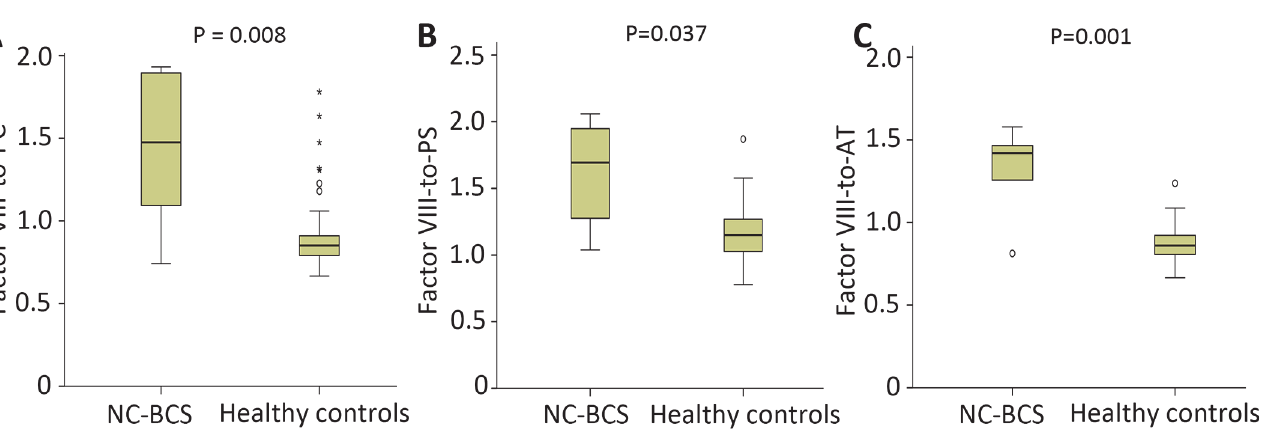
Fig 1. Box plots for the ratios of factor VIII-to-PC, factor VIII-to-PS, and factor VIII-to-AT between patients with non-cirrhotic Budd-Chiari syndrome (NC-BCS) and healthy